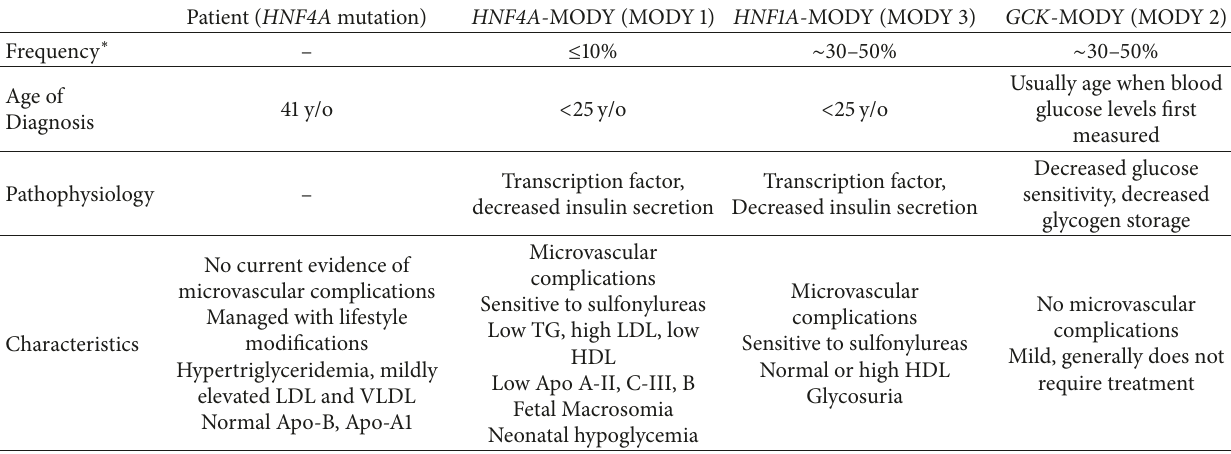
Table 1: Comparison of patient phenotype with the common MODY subtypes.